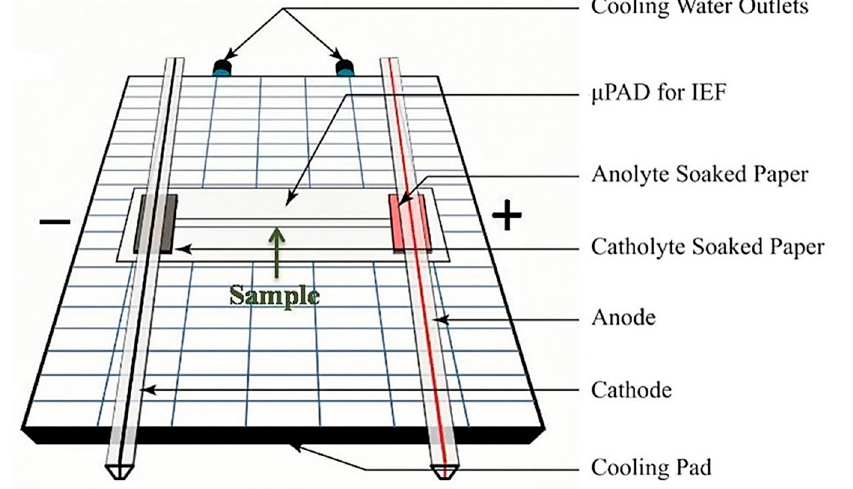
Figure 20. Schematic design of the µ PAD used by Yu et al. The device was placed on a cooling pad and the connections were fixed to the anolyte and catholyte soaked paper. (Re-printed from Yu et al. [147], with permission from Springer – permission pending).